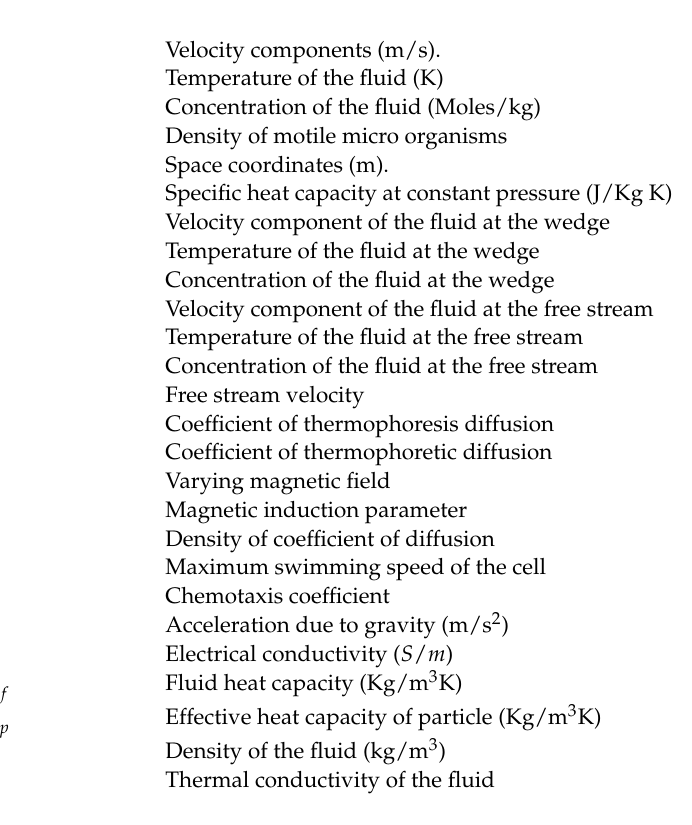
Figure 1. Physical con fi guration of Falkner–Skan fl ow model.